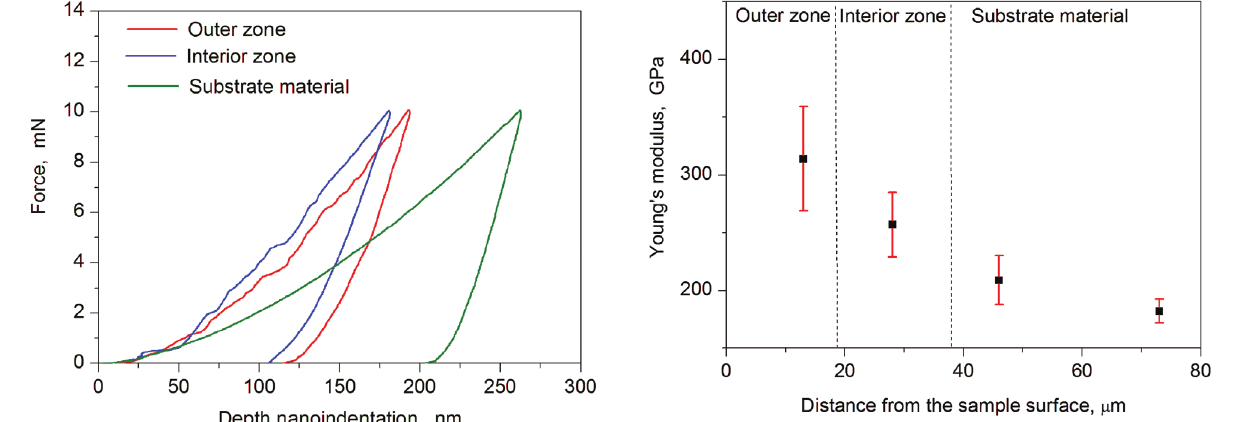
Figure 13: The load changes in the depth function of the penetrator in different zones of the aluminide coating and substrate material (core) of superalloy Inconel 625, process time 8 h.